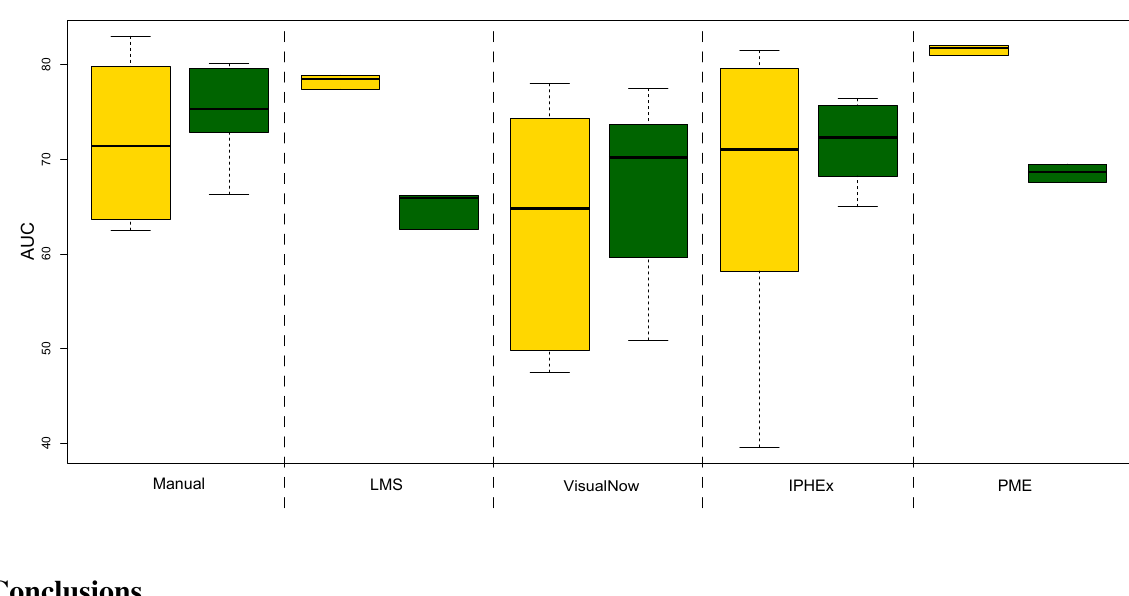
Figure 5. Boxplots illustrating the variation within the linear SVM tuning results in a single ten-fold cross validation run. The yellow boxes show the results when tuning the original feature sets. The green boxes show the results when tuning the randomly labeled feature